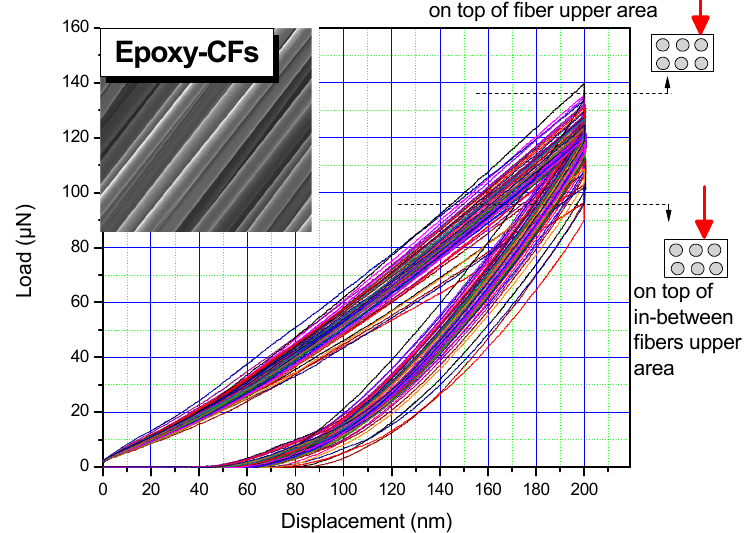
Figure 3. Load ‐ displacement data from the loading ‐ unloading mapping measurements at 200 nm of displacement, for the epoxy ‐ CF plain sample.